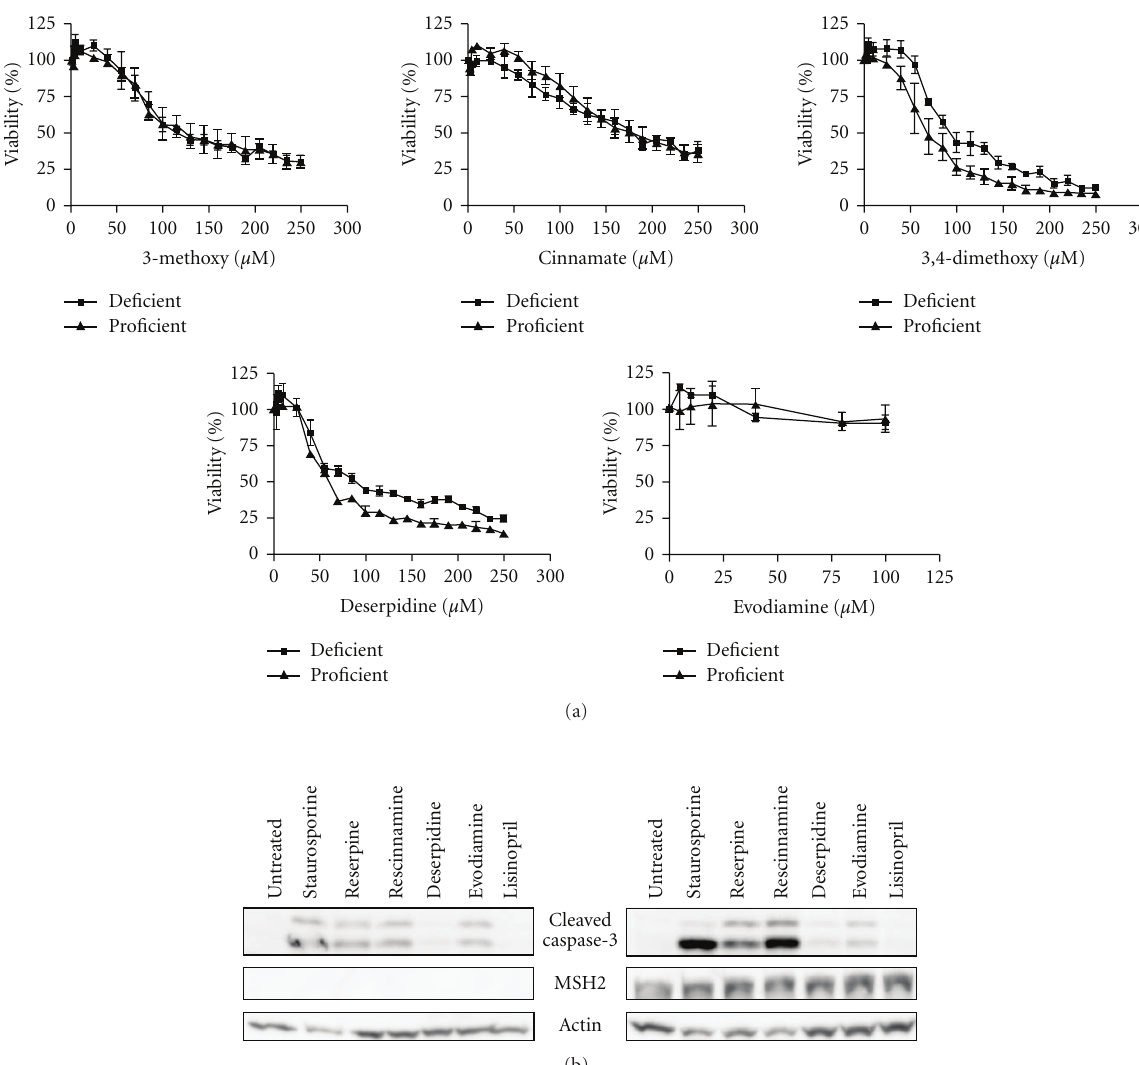
Figure 6: (a) Derivatives of reserpine and rescinnamine diminish cell viability in an MSH2-independent manner as shown by MTS assays with an exception of 3,4-dimethoxy reserpine, which demonstrates a slight dependence on MSH2. Evodiamine has an insignificant e ff ect on cell viability. One representative from each of the predicted binding mode groups is shown. MSH2-deficient cells ( (cid:2) ) and MSH2-proficient ( (cid:3) ) cell response is shown. (b) Caspase-3 cleavage was assessed in Hec59 ( MSH2 -deficient; left panel) and Hec59(2) ( MSH2 -proficient; right panel) cells when treated with various compounds. The 17 and 19kDa cleavage products of caspase-3 are depicted. Staurosporine (STS) was used as a positive control; actin was used as a loading control. Lisinopril is an ACE inhibitor, like rescinnamine, and demonstrates rescinnamine’s action as being independent of its antihypertensive